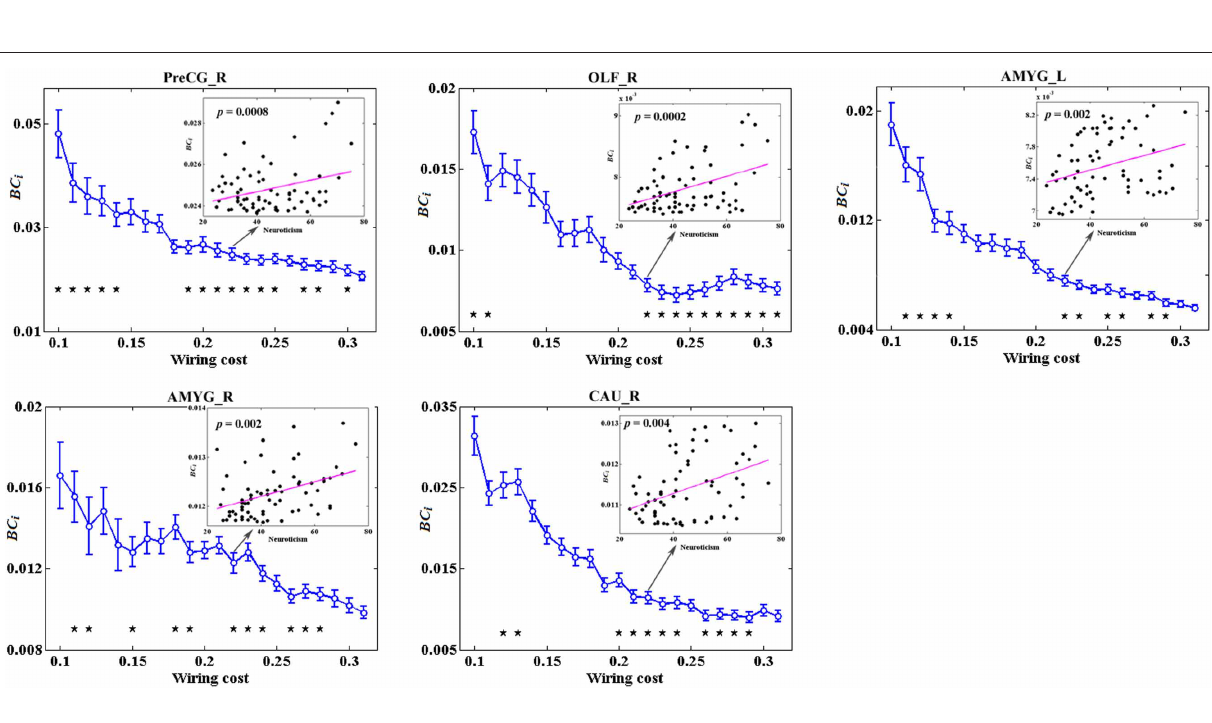
FIGURE 5 | The topological characteristics of BC i as a function of wiring cost thresholds, in the brain regions whose BC i values have significant associations with neuroticism. The asterisk also indicates the threshold